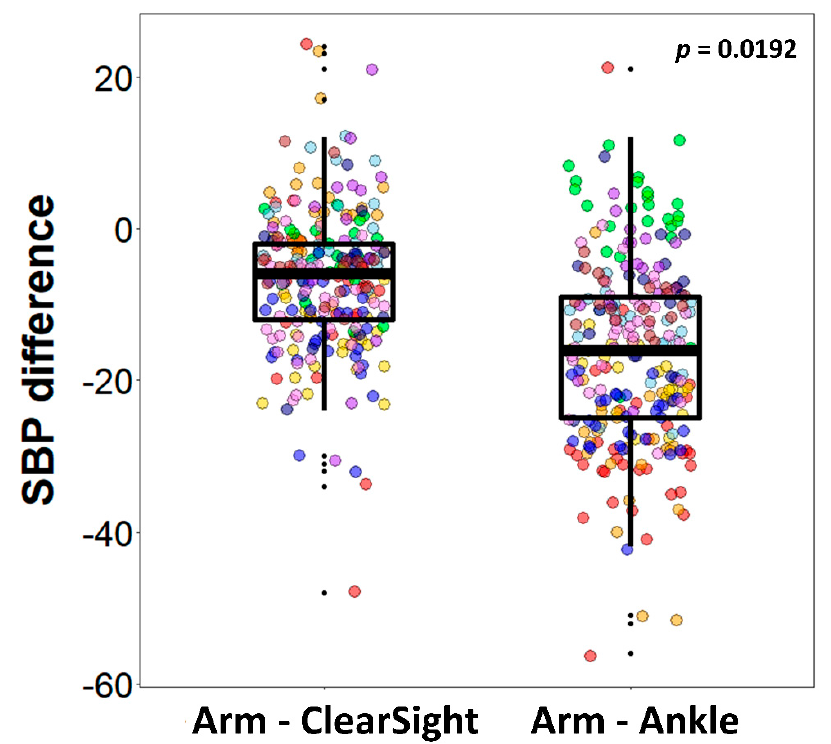
Figure 4. The boxplot showing the differences of CNBP SBP and ankle SBP from arm SBP. Each color of dots represents each patient.